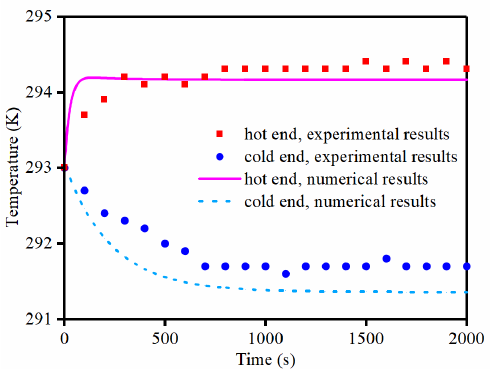
Figure 4. Fluid temperatures obtained experimentally and